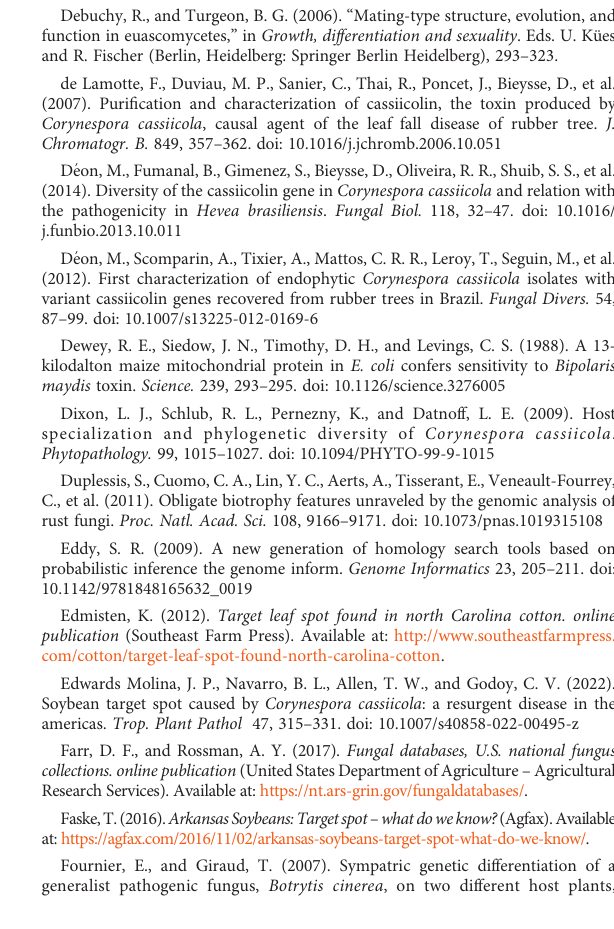
SUPPLEMENTARY FIGURE 1 Gel image of PCR products ampli fi ed by the multiplexed PCR-based mating-type assay for C. cassiicola . Fragment sizes are 1494 bp for isolates with MAT1-1 (lane indicated by “ 1 ” ) and 998 bp for isolates with MAT1-2 (lane indicated by “ 2 ” ). “ M ” indicates the lane with the size marker. Isolate names are listed at the top of each